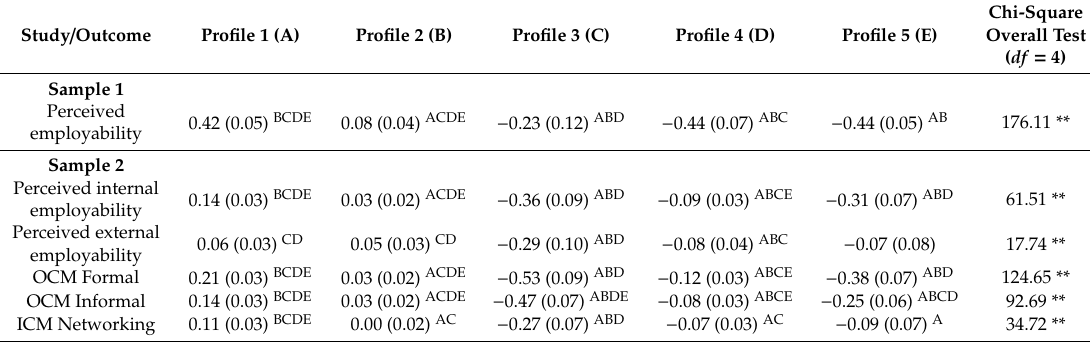
Table 3. Equality tests of means (SD) across the profiles using the BCH procedure.